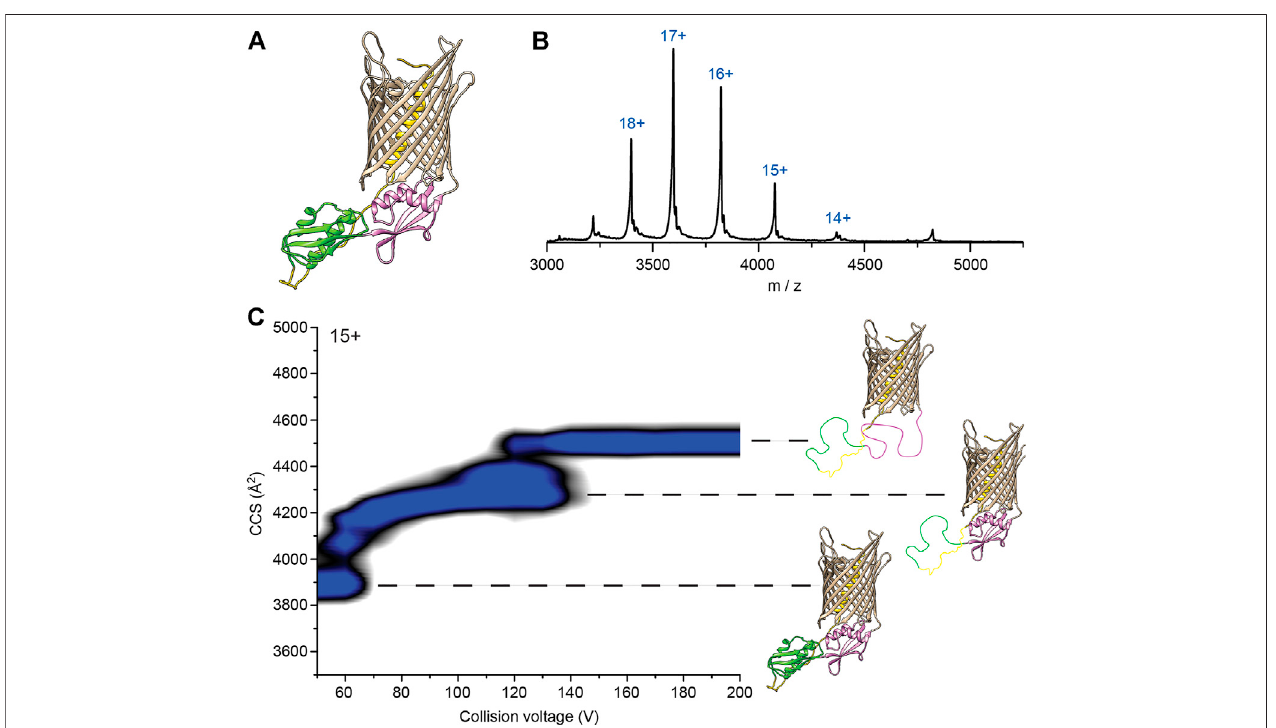
FIGURE 5 | Native mass spectrometry analysis of WT FhaC. (A) Model of FhaC with H1 and the linker in yellow, and the POTRA1 and POTRA2 domains in green and pink, respectively. (B) Mass spectrum of WT FhaC released from its bOG micelle. The ionization state of the protein is indicated above each peak. (C) CIU experiments show two dominant transitions that are likely linked to unfolding of the two POTRA domains (see text). The order in which they unfold is unknown and is depicted here in an arbitrary